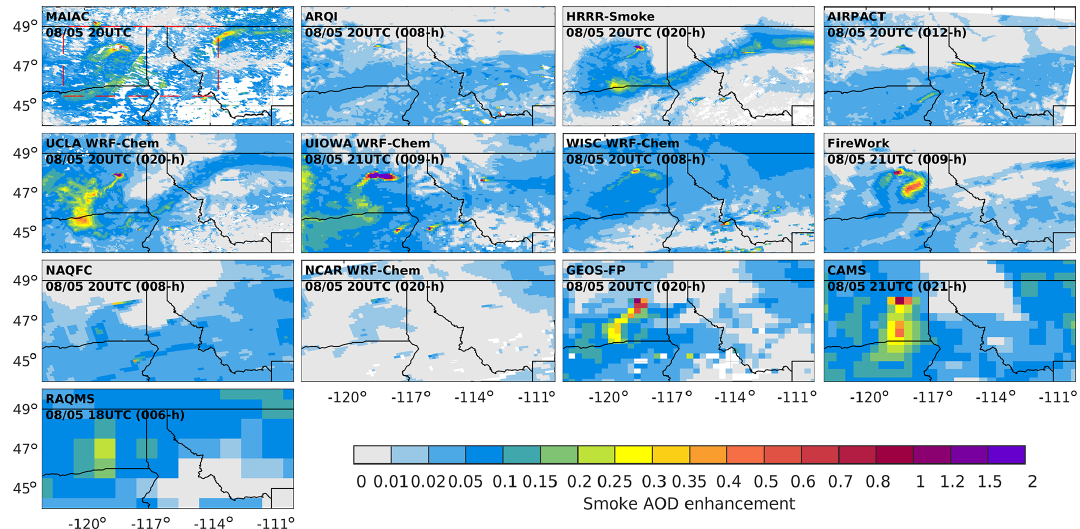
Figure 7. Map of observed smoke AOD enhancements (sAOD) by MODIS MAIAC data and the model forecasts for 20:00UTC 5 Au- gust 2019. The valid time of forecast is shown on each panel (with the lead time in parenthesis, e.g., 008h for 8h forecast after the model initialization). The dashed red box on the observation map represents the area of interest for the evaluation of sAOD magnitude and spatial extent of the smoke